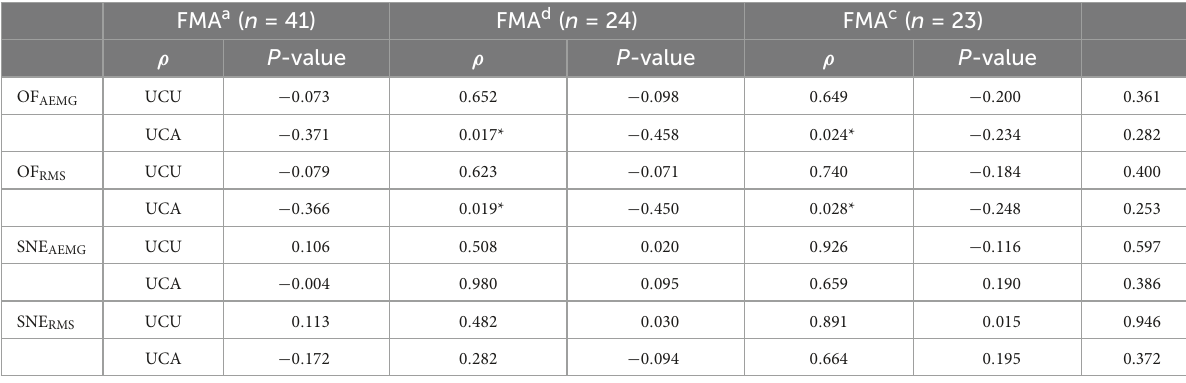
TABLE 5 Spearman correlation coefficients ( ρ ) for OF/SNE and FMA.